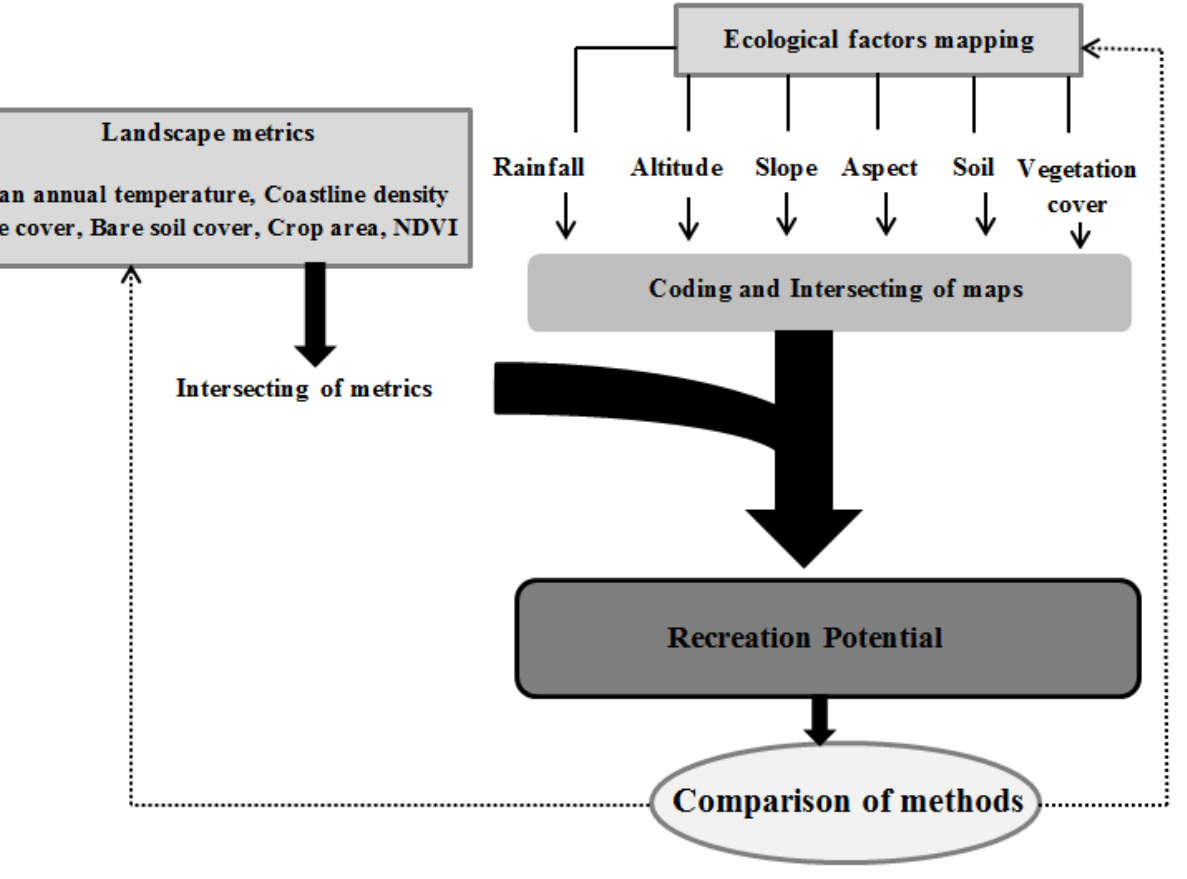
Figure 2. Conceptual framework of research